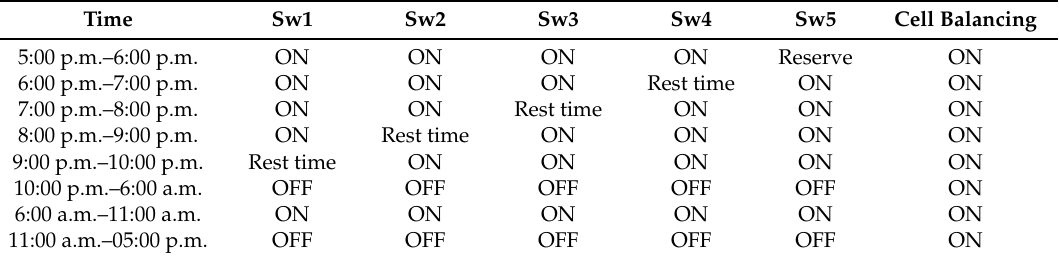
Table 2. Proposed operational schedule for battery management system